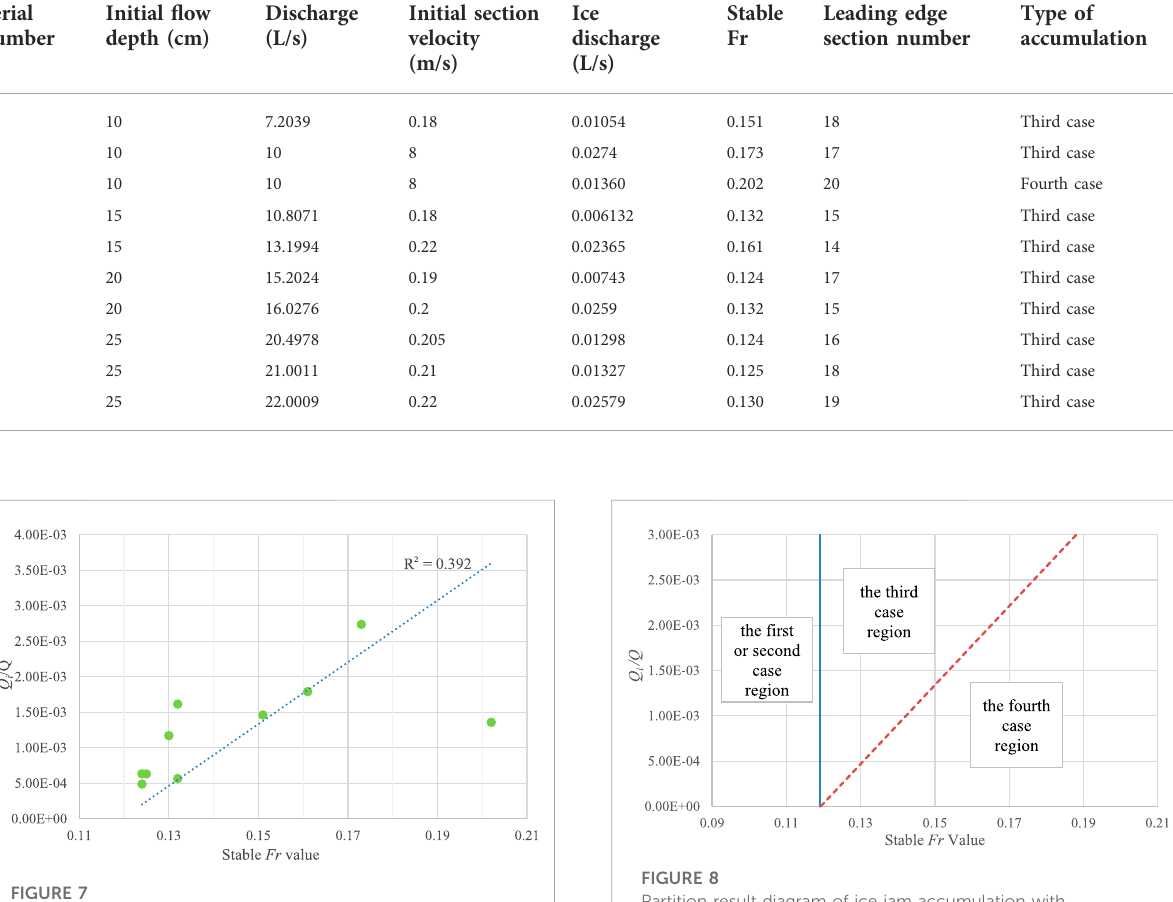
FIGURE 7 Critical conditions for failure to form ice jams.